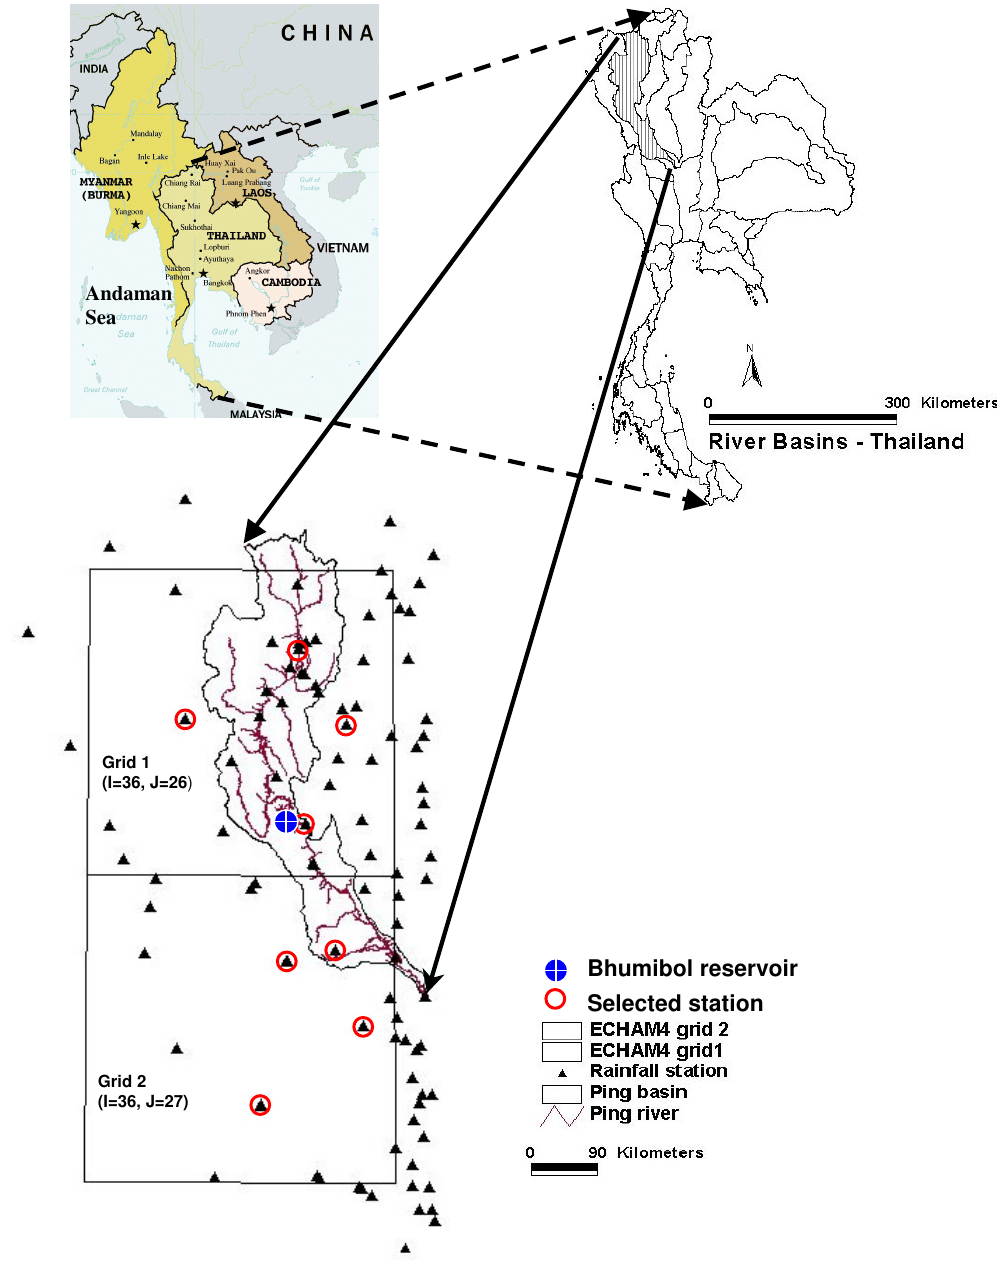
Fig. 1. Location map of Ping River